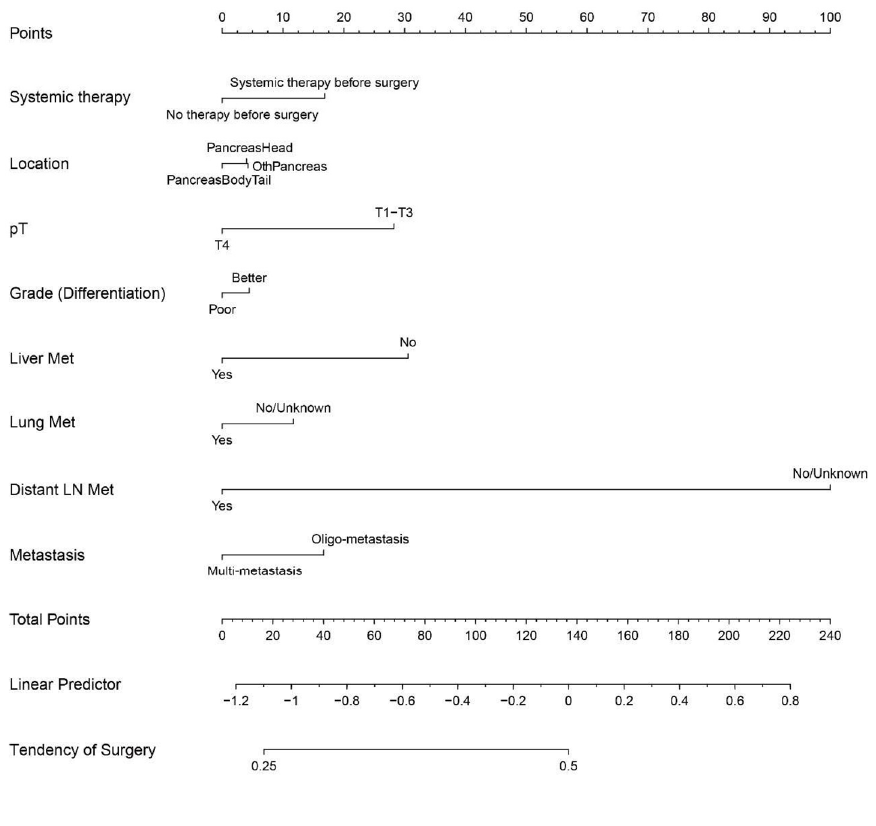
Figure 6. Nomogram for a preliminary prediction of surgery.